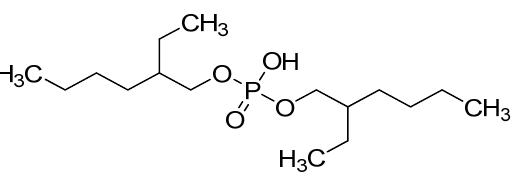
Figure 1. The structure of di(2 ‐ ethylhexyl) phosphoric acid (D2EHPA).